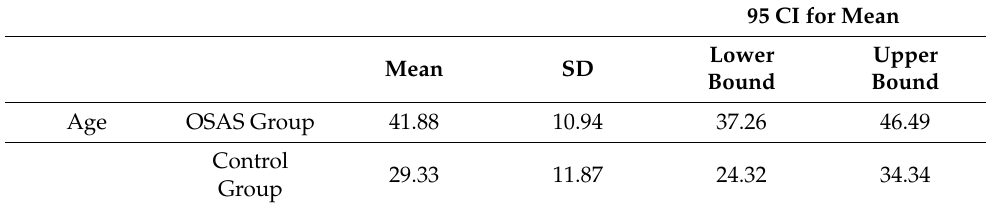
Table 3. Mean age in the study